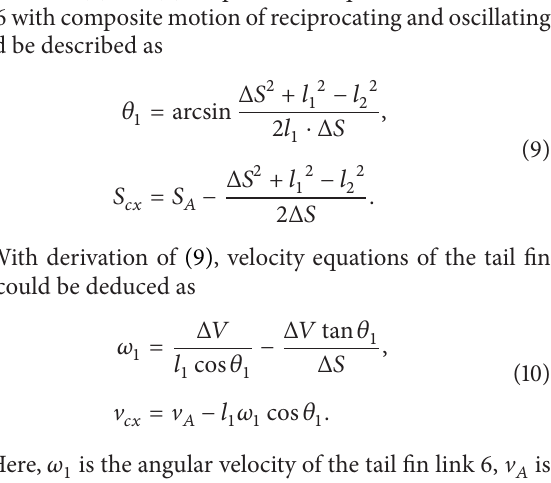
Based on (7) and (8), displacement equations of the tail fin link 6 with composite motion of reciprocating and